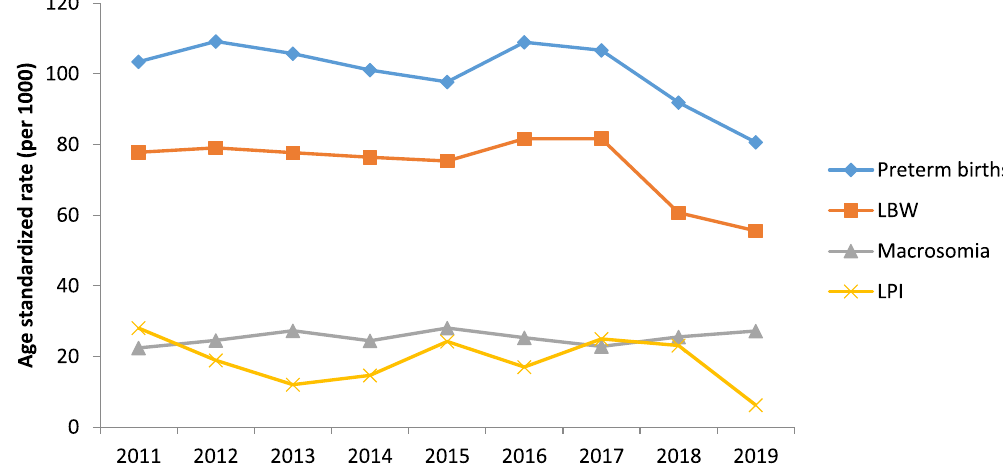
Figure 1. Trend of adverse of perinatal outcomes across different years of study (2011–2019).